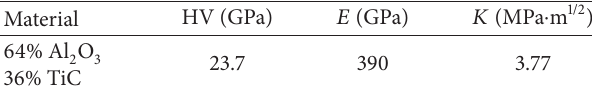
Table 2: Mechanistic properties of magnetic head